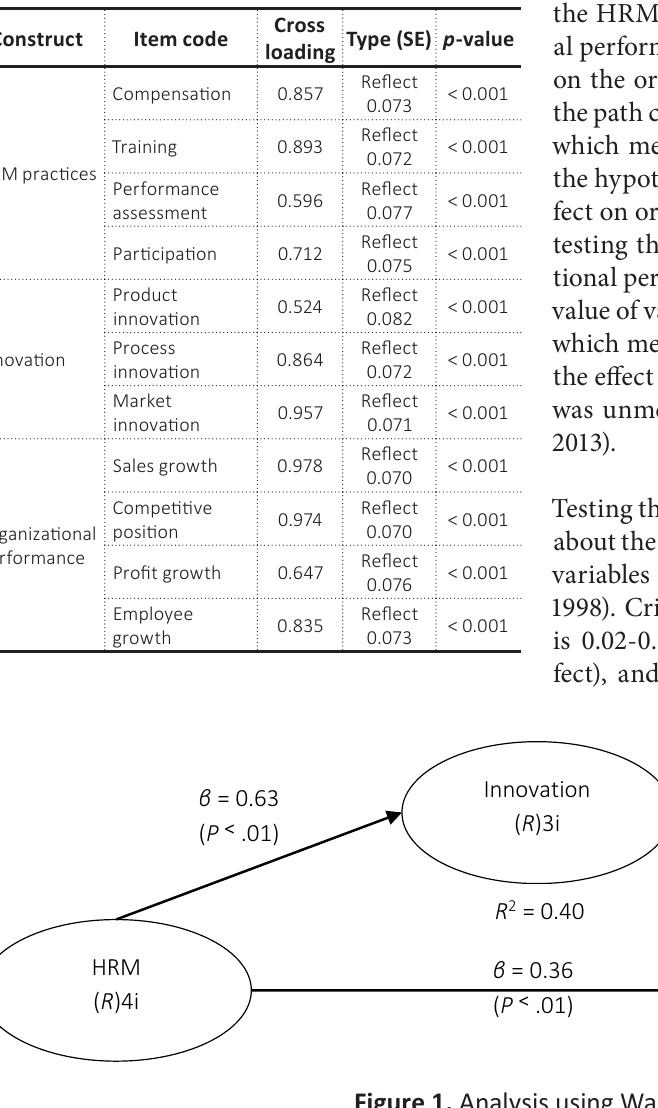
Table 4. The outer model’s measurement analysis